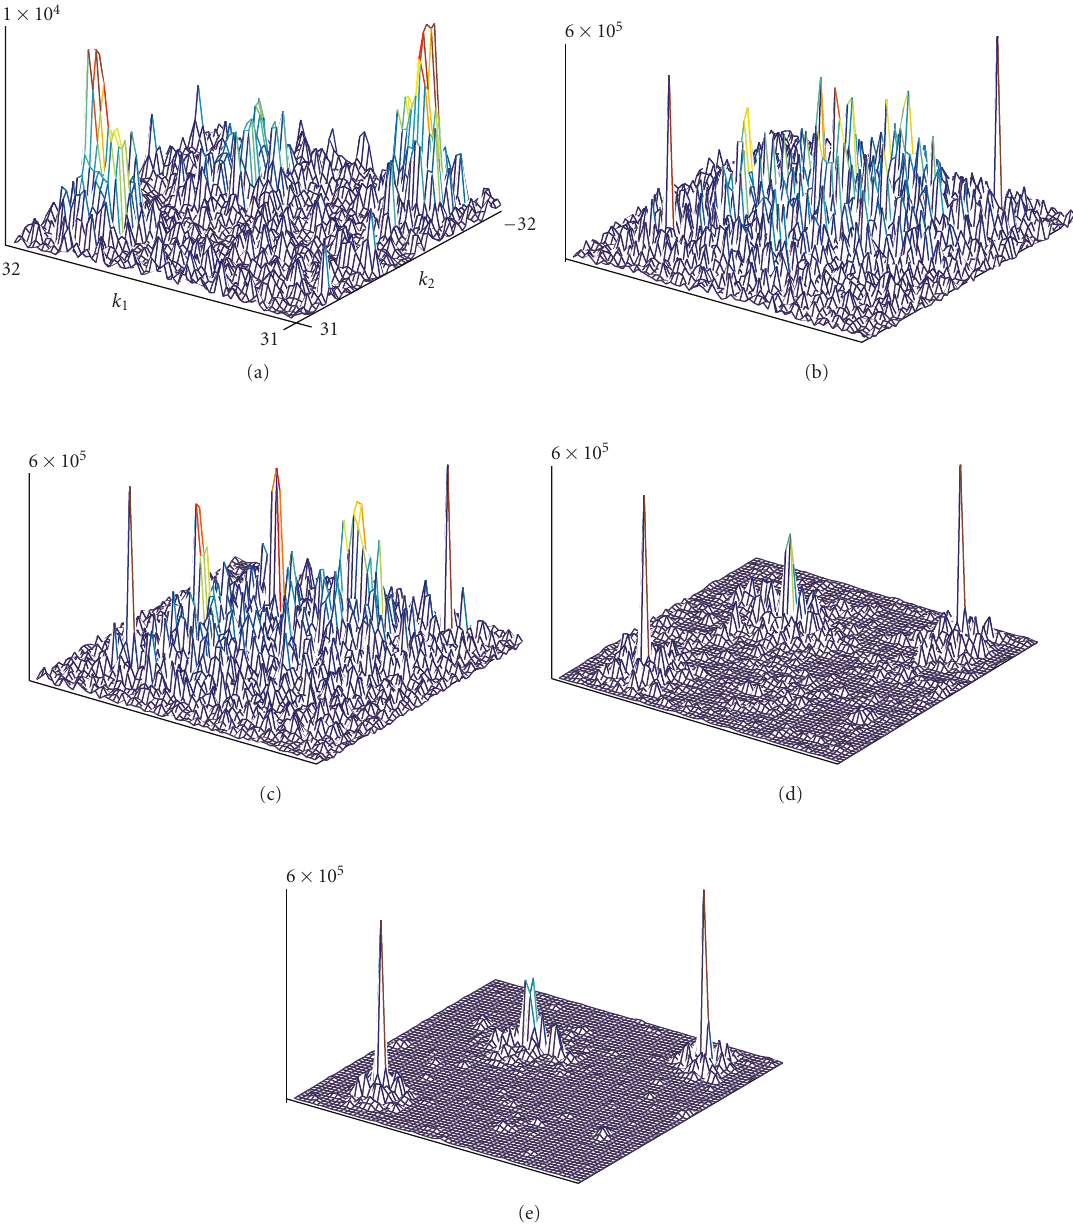
Figure 3: S/SFDs of noisy signal (5): (a) 2D SPEC, (b) 2D WD, (c) 2D SM corresponding to the widest signal component, (d), (e) proposed method based S/SFDs corresponding to R 2 of 1% and 5% of the expected 2D SPEC’s maximum value.